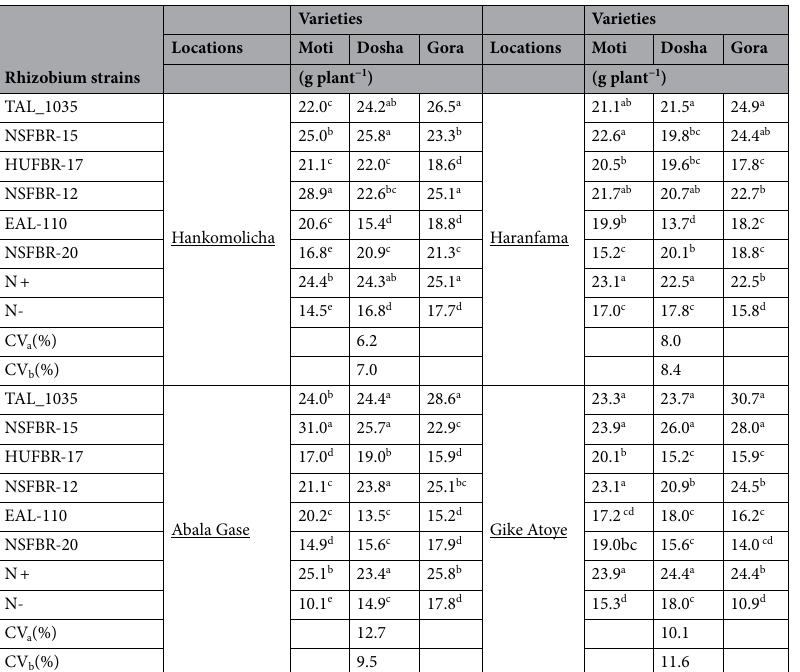
Table 7. Rhizobium strain x faba bean variety interaction effects on shoot dry weight at late flowering stage. Mean values in the same column with different letter(s) are significantly different at p ≤ 0.05 probability